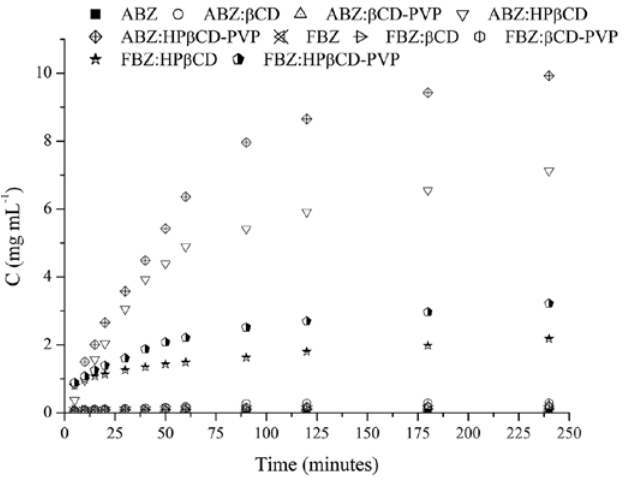
FIGURE 6 - Amount dissolved versus time obtained for the drugs (ABZ and FBZ) and their binary and ternary